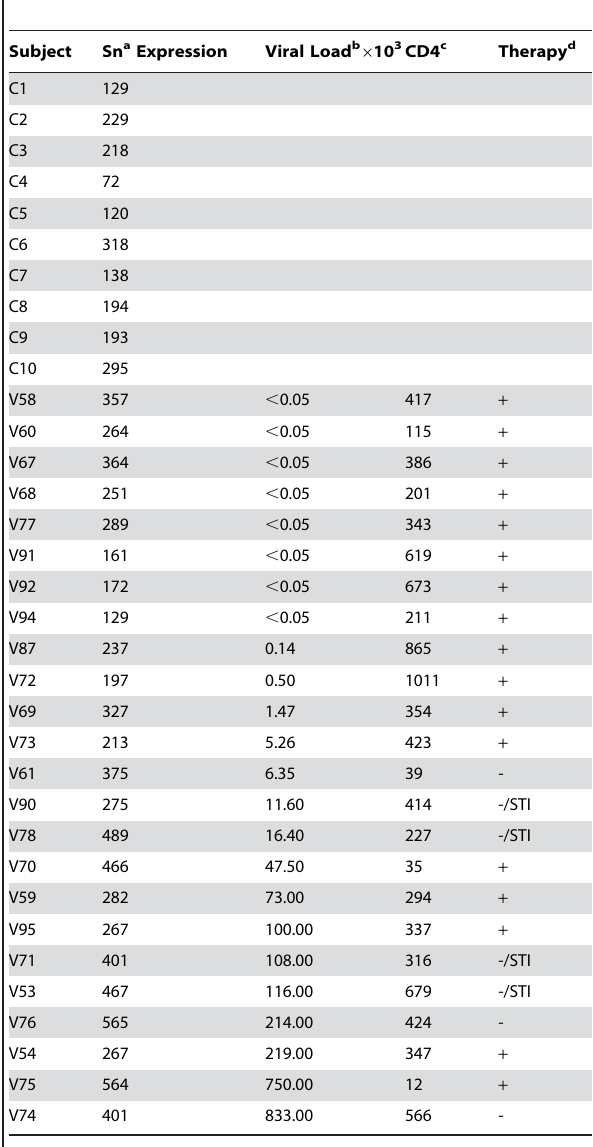
Data for controls (C, n=10), HIV-1 seropositive subjects (V, n=24) Data sorted on increasing viral load